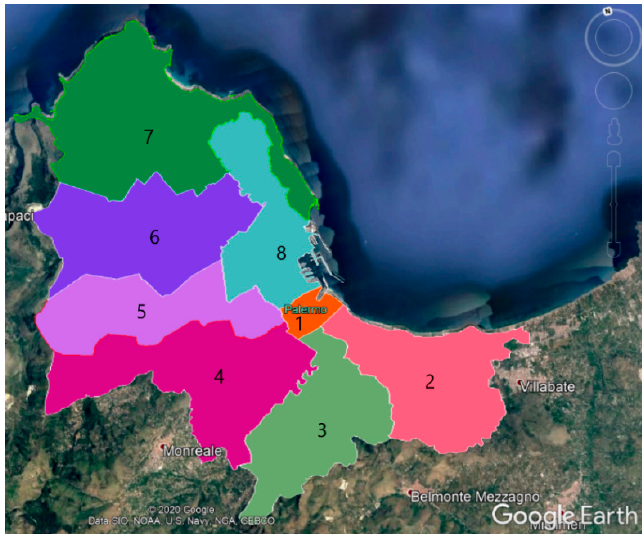
Figure 4. Circumscription divisions within Palermo (screenshot taken from Google Earth [69]).